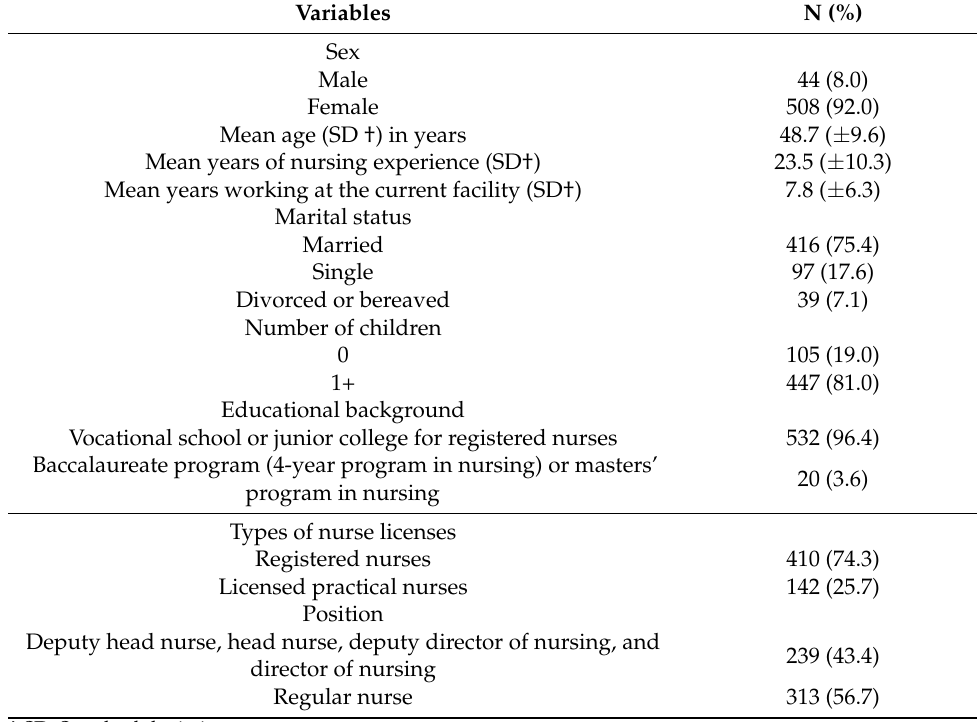
Table 1. Participants’ basic attributes (N =